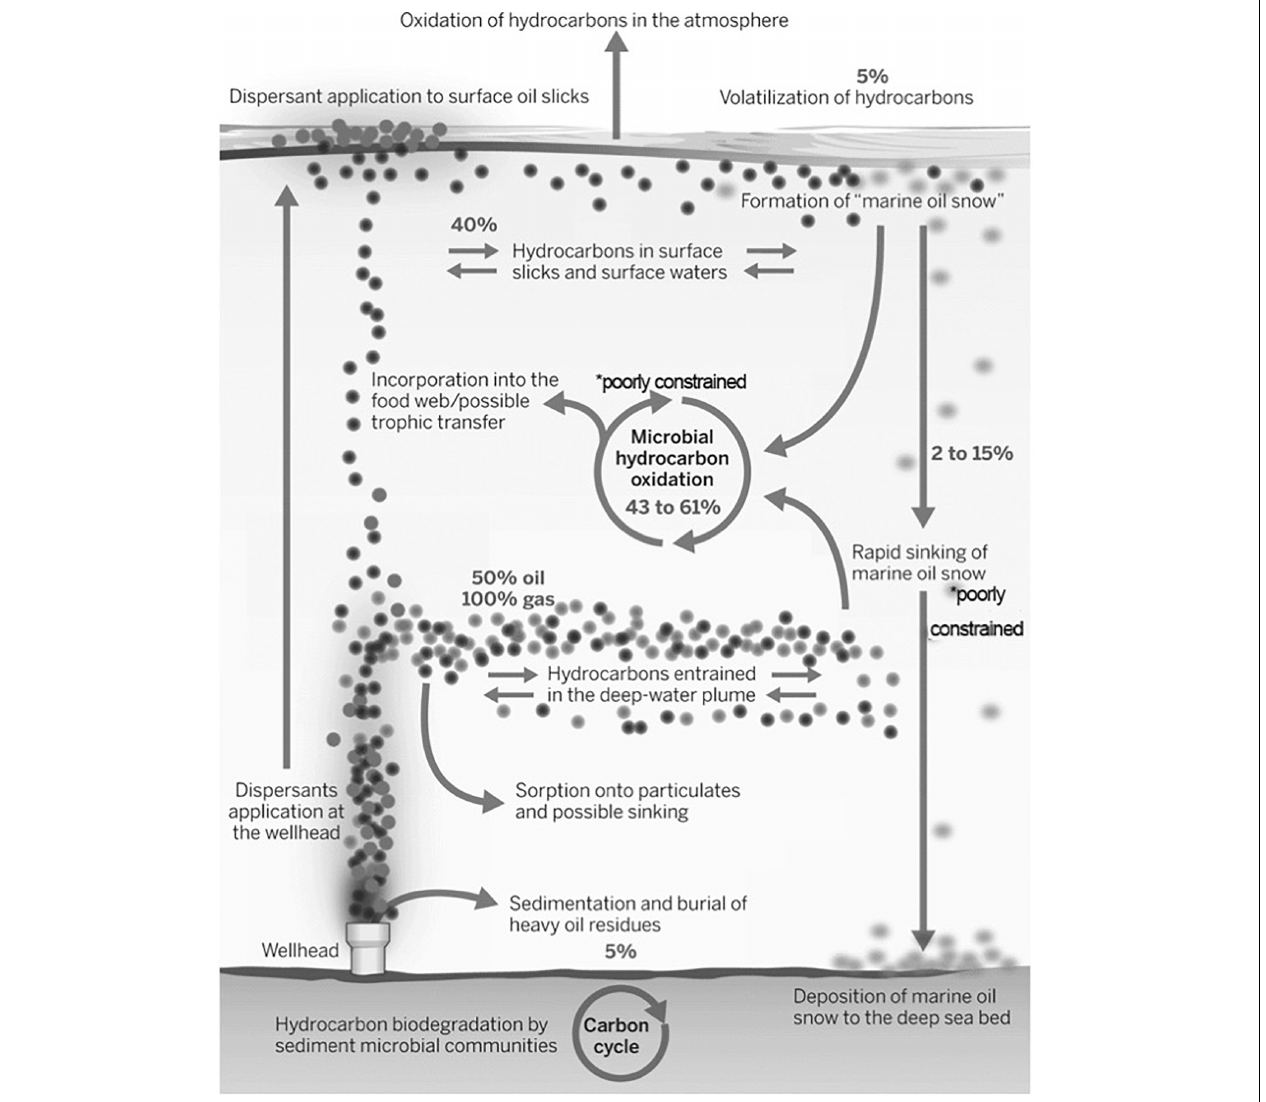
FIGURE 6 | Approximate (likely) distribution of oil (darker circles) and gas (lighter circles) during the Deepwater Horizon well blowout; dispersant addition is also noted, and so is the deep plume contribution. Available data suggest that the long-term fate is known for only up to 76% of the discharged hydrocarbons. Oil that may have deposited in beaches and coastal marshes is not accounted in the figure. Modified from Joye